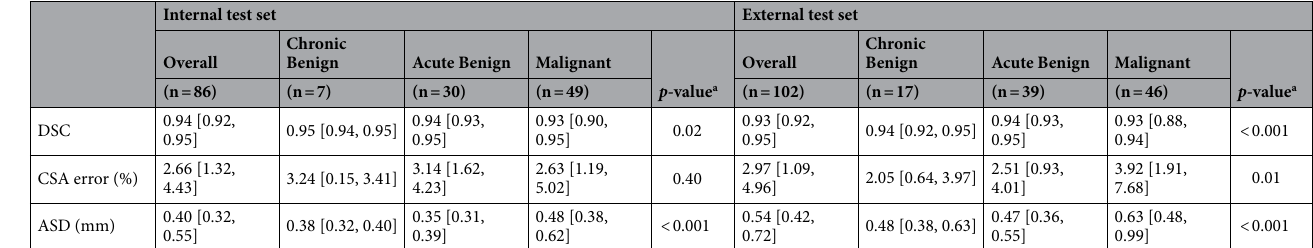
racy of the deep-leaning based automated segmentation algorithm is summarized in Table 3. The algorithm achieved high agreement with the ground truth by human experts for segmentation of fractured vertebral bodies on the two independent test sets, with overall median DSCs of 0.94 and 0.93, CSA errors of 2.66% and 2.97%, and ASDs of 0.40 mm and 0.54 mm, on the internal test and the external test, respectively. Representative images of automated segmentation of fractured vertebral bodies are shown in Fig. 3. The median runtime for automated segmentation of a vertebral body with fracture 1.18 s (range, 0.87–1.51 s). Subgroup analysis showed that the algorithm achieved the highest performance for chronic benign fractures, followed by acute benign fractures and malignant fractures, with statistically significant differences, except for the CSA error of the internal test set.